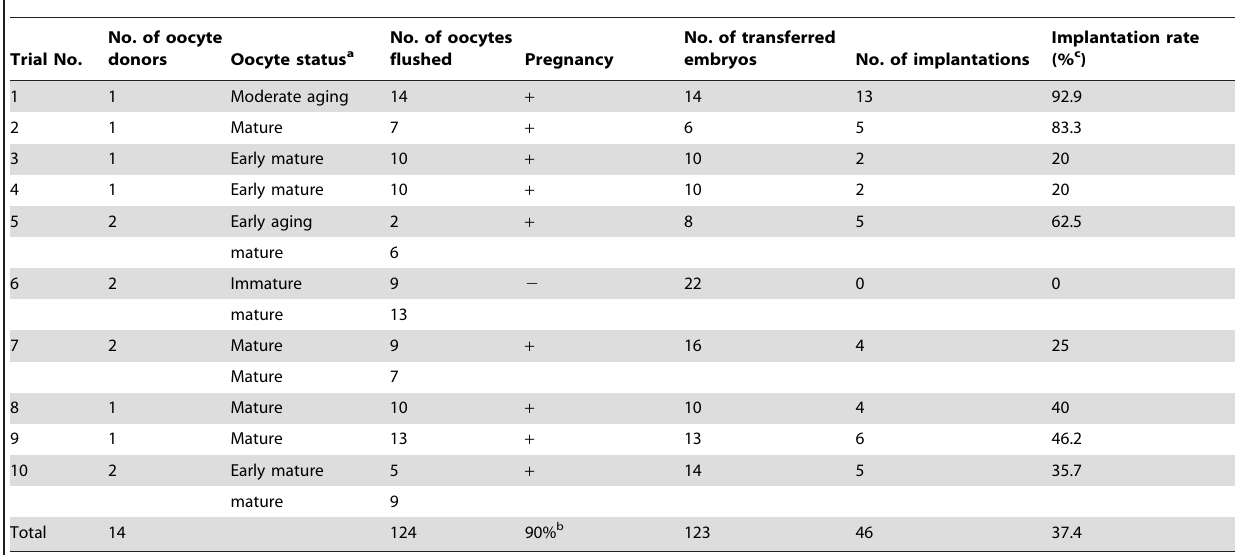
Table 3. Post-implantation development of canine parthenogenetic embryos.